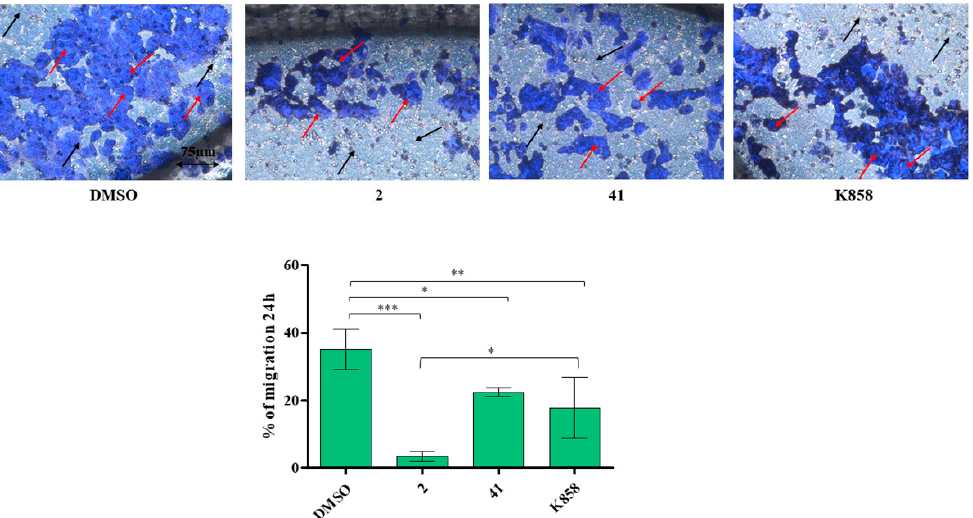
Figure 7. Transwell migration assay of MCF7 treated with compounds 2 (1.5 µ M), 41 (5 µ M), and K858 (10 µ M). Images represent migrated cells after crystal violet staining. Histogram represents densitometric analysis obtained by quantifying thresholded area for violet color in 10 fields for each of three slides per sample. Magnification 20 × . Dark blue represents stained invasive cells (red arrows), light blue surface represents the insert with pores (black arrows). *** p < 0.0001; ** p < 0.001; * p < 0.01. DMSO: control vehicle. Data are presented as mean ± SD.